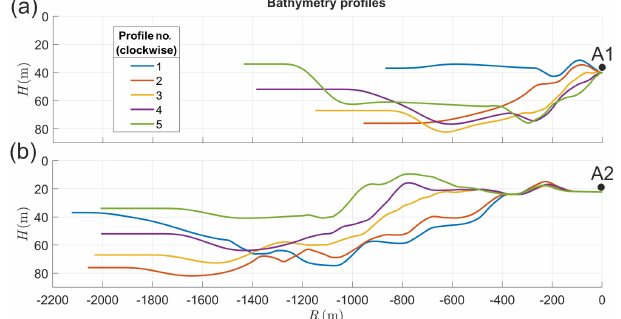
Figure 3. Bathymetry profiles between the terminus of Hansbreen and the two acoustic buoys: A1 (a) and A2 (b) . The spatial arrange- ment of the transects, which are numbered clockwise, is shown in Fig. 1. The horizontal axis is zeroed at locations of the buoys, marked with black dots. Bathymetric data provided by the Norwe- gian Hydrographic Service under the permit no. 13/G722, issued by the Institute of Geophysics, Polish Academy of